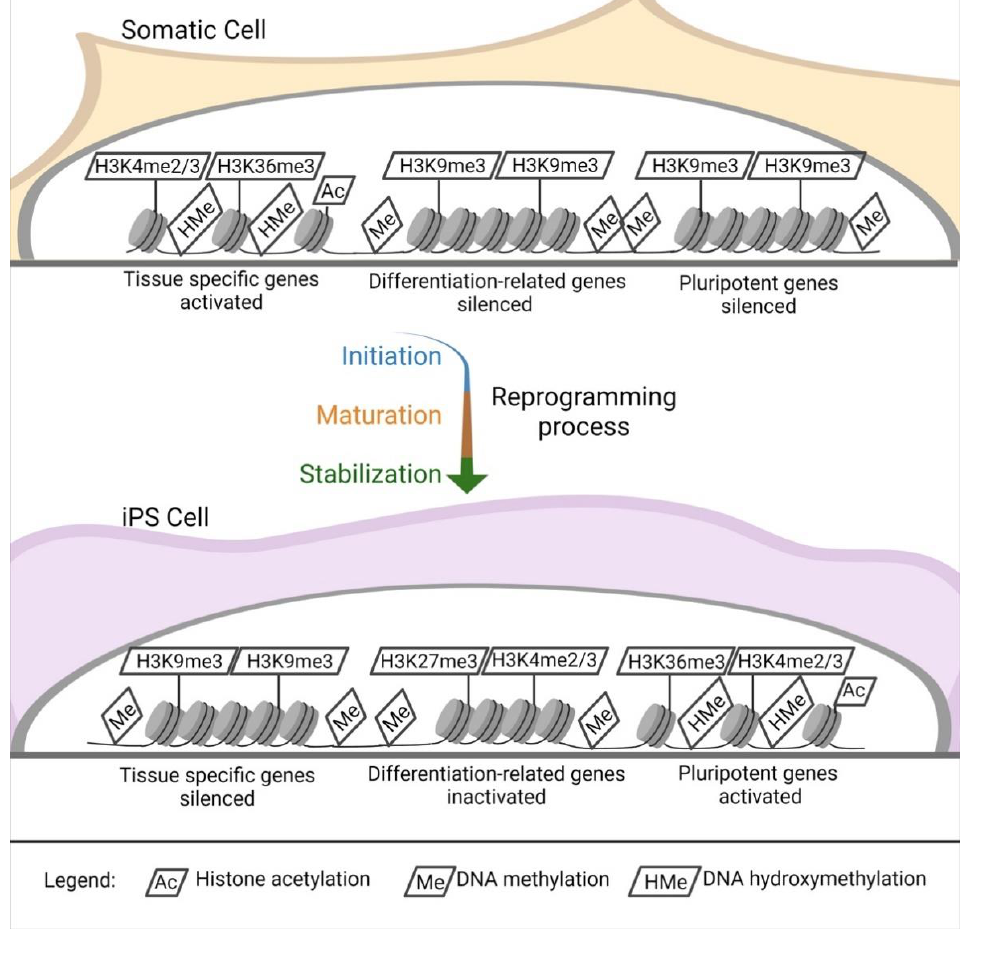
Figure 2. Epigenetic landscape changes. DNA and histones modification in the reprogramming process. Starting from a somatic cell throughout the reprogramming process (initiation, maturation, and stabilization), there is an intense modification of the histones and DNA in specific